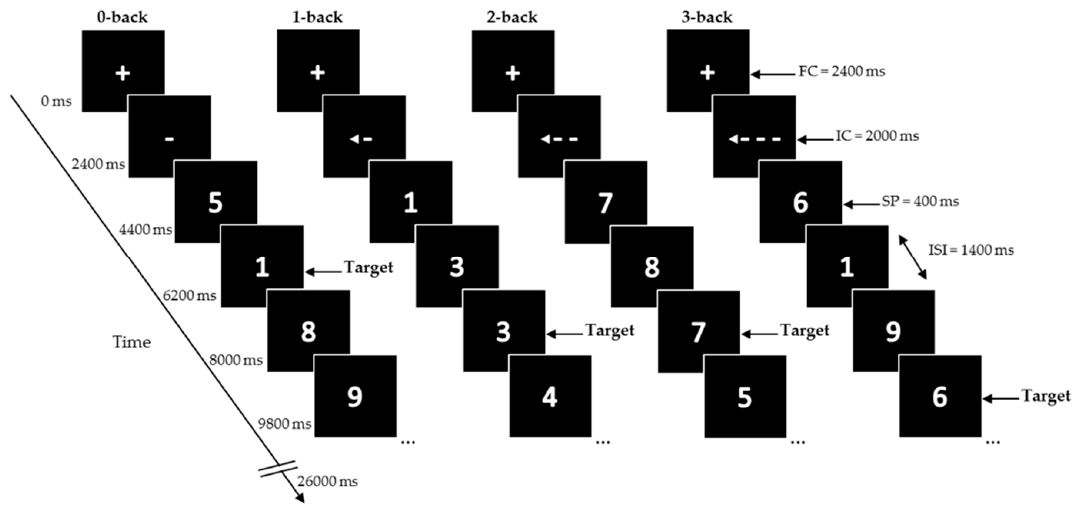
Figure 2. Schematic overview of the numerical N-back task.